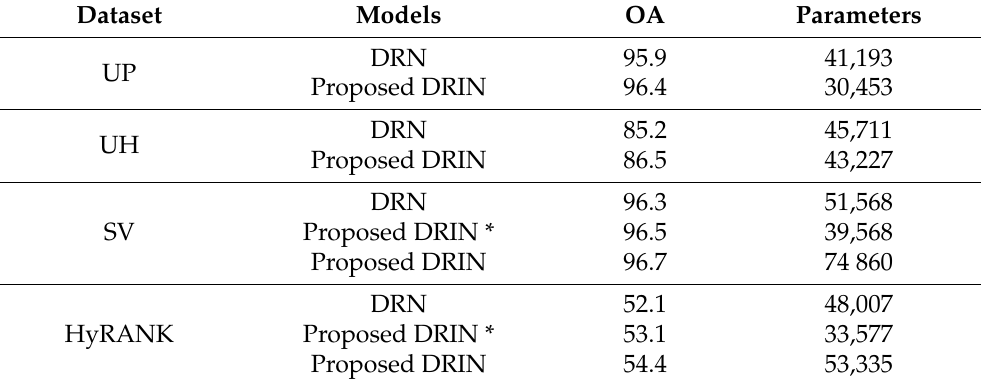
Table 13. Performance comparison between the DRN and the proposed DRIN. We showcase both the OA and the amount of model parameters. Note that DRIN * refers to the proposed model with a smaller involution kernel.